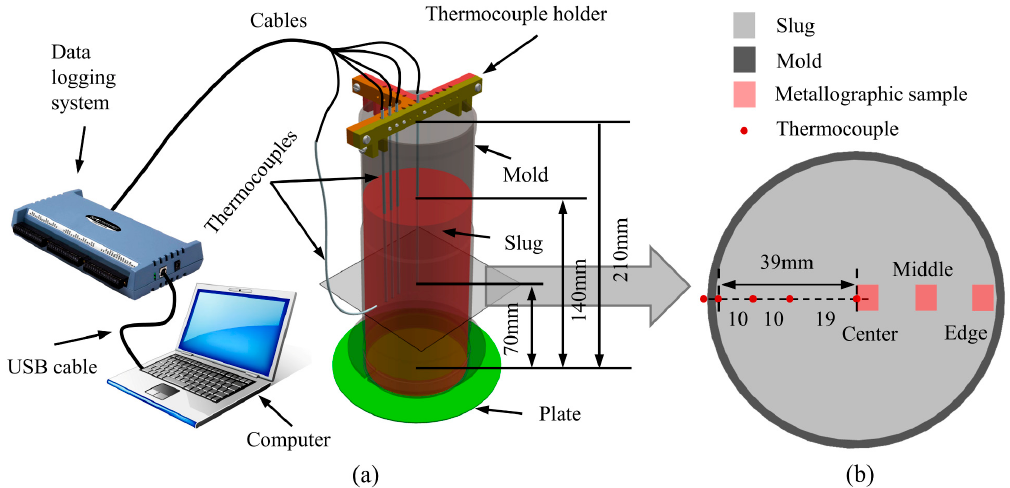
Figure 3. ( a ) Diagram of temperature acquisition system. ( b ) Distribution of thermocouples and metallographic samples in the radial direction.